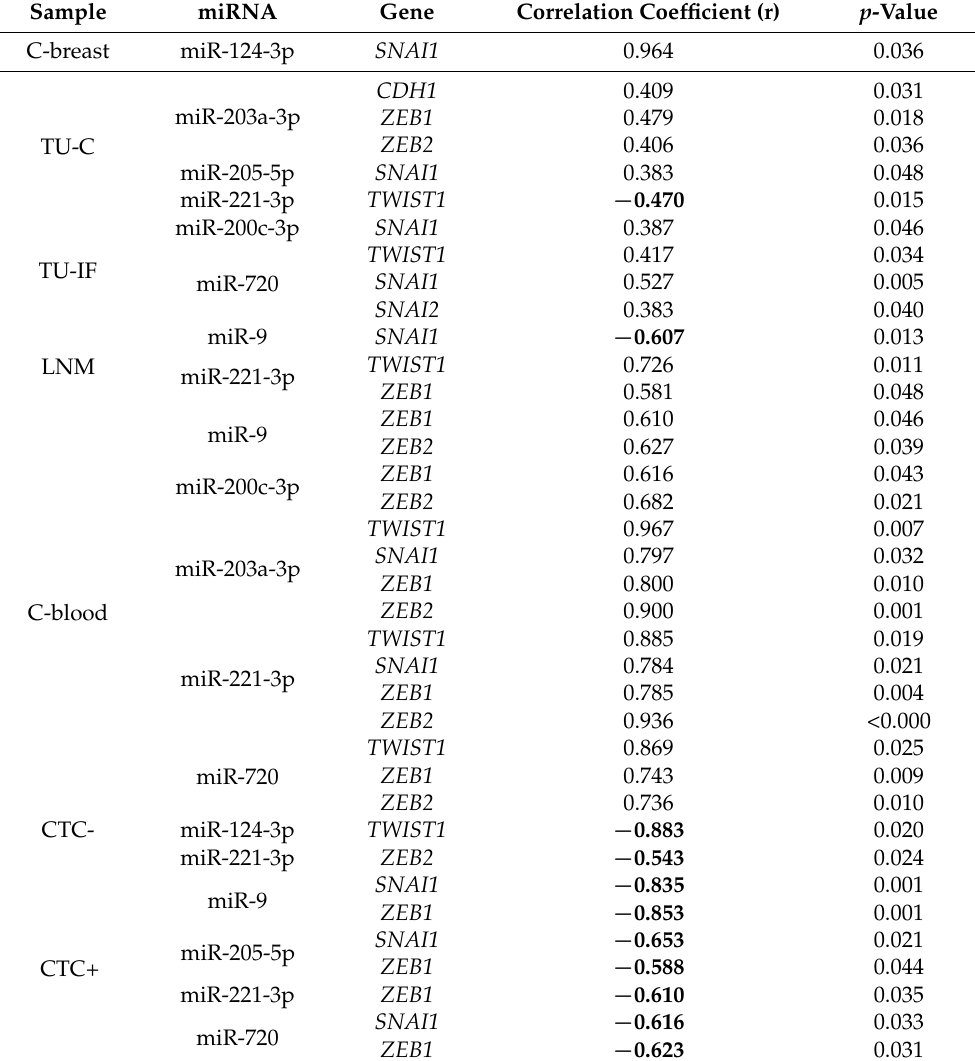
Table 2. Significant correlations between miRNA and mRNA of CDH1 , and EMT gene expressions in BC